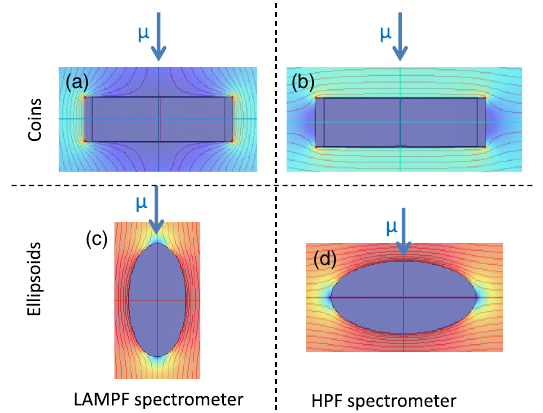
FIG. 7. Four generic arrangements of sample, muon and field direction using the LAMPF and HPF spectrometers. Red/blue color indicates areas of high/low magnetic field (compare to flux line density). The direction of the muon spin is always perpendicular to the beam direction, the sample surface and the applied field. (a) Note the high flux line density at the edges of the coin in the transverse geometry (LAMPF). (b) In the parallel geometry (HPF) the field enhancement at the edges is much weaker. (c,d) For the ellipsoid there is no edge boundary. Here the field will first nucleate at the equator, where the muons are implanted in the HPF setup. Simulations have been performed with Comsol Multiphysics assuming the samples to be in a perfect Meissner state (relative magnetic permeability μ r ¼ 0 ).